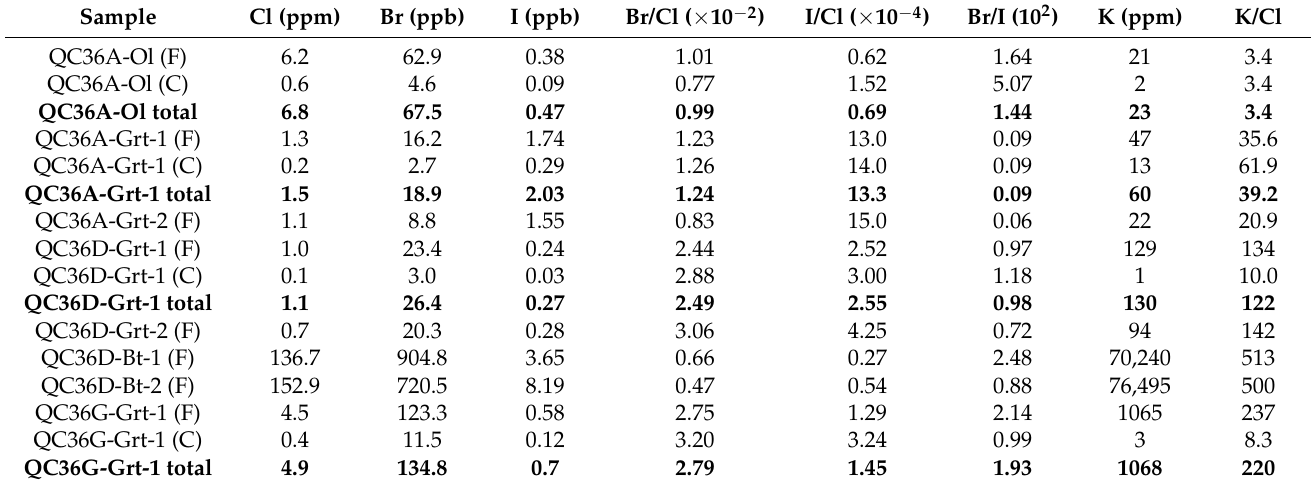
Table 5. Halogen and K abundances and ratios obtained by crushing and heating analyses of Svartberget